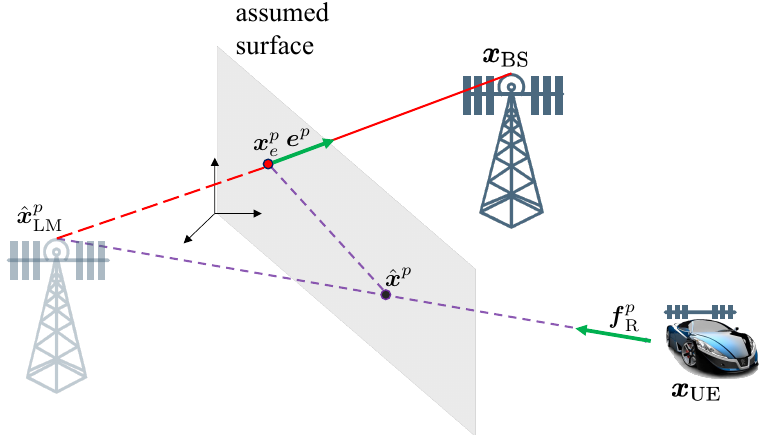
Figure 4. Illustration of the 3D transformation from the 5D parameters: from the channel estimates, a hypothesized landmark (a virtual anchor) location ˆ x p locations, the incidence point ˆ x p is